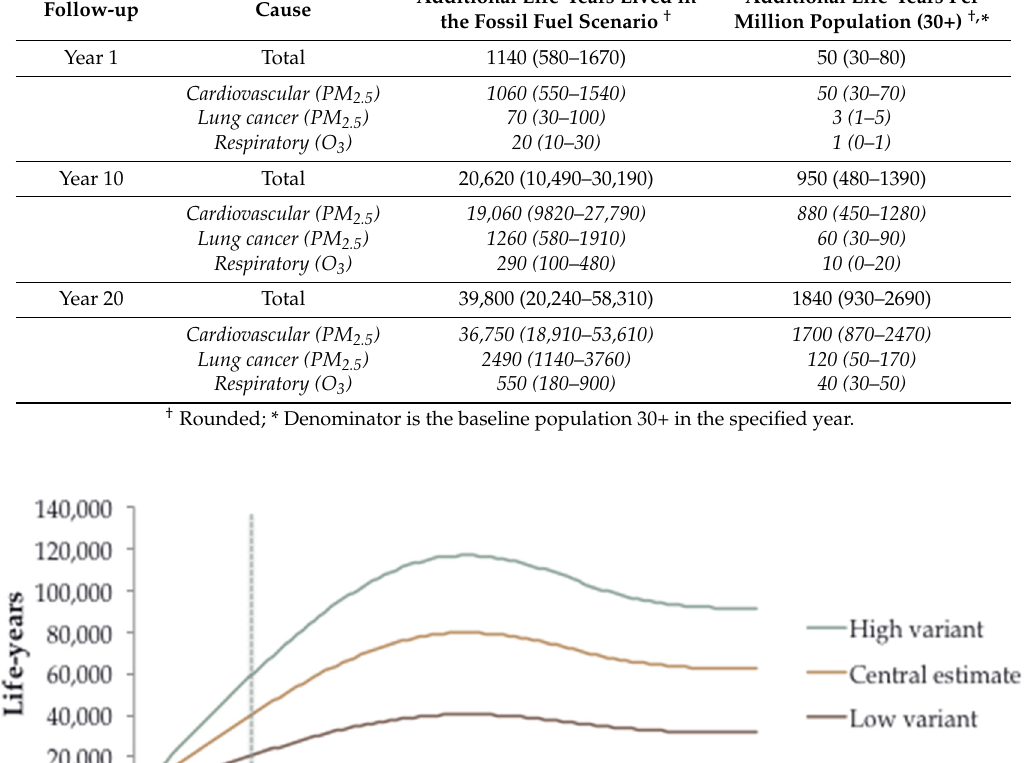
Table 2. Additional life-years lived per year by the population in the Fossil Fuel compared to the Ethanol Expansion scenario at three time points (Year 1, Year 10 and Year 20). Follow-up